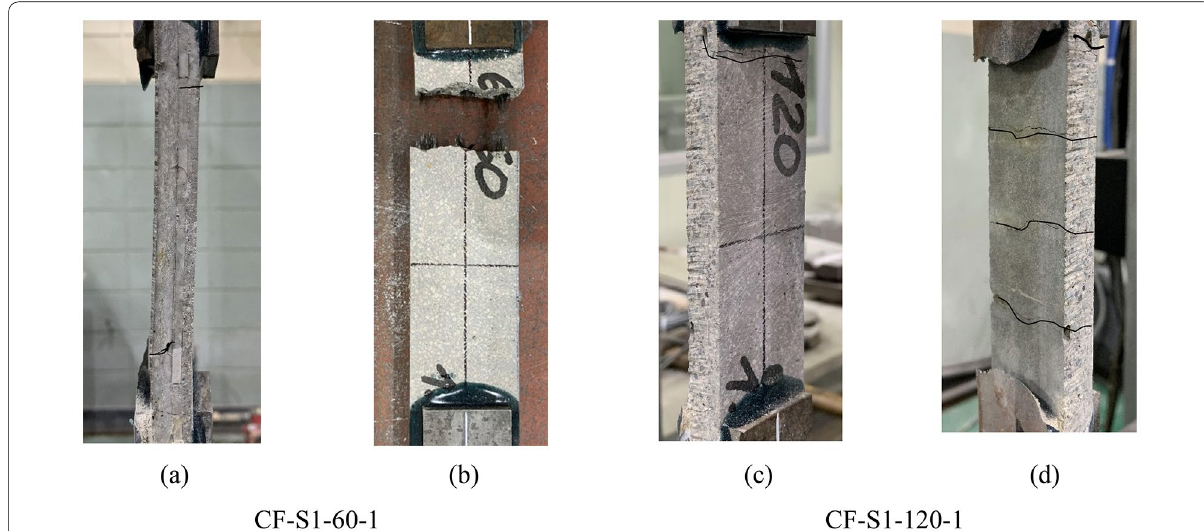
Fig. 10 Lap-splice test: crack and failure patterns. a Cracking, b failure, c cracking, d multiple